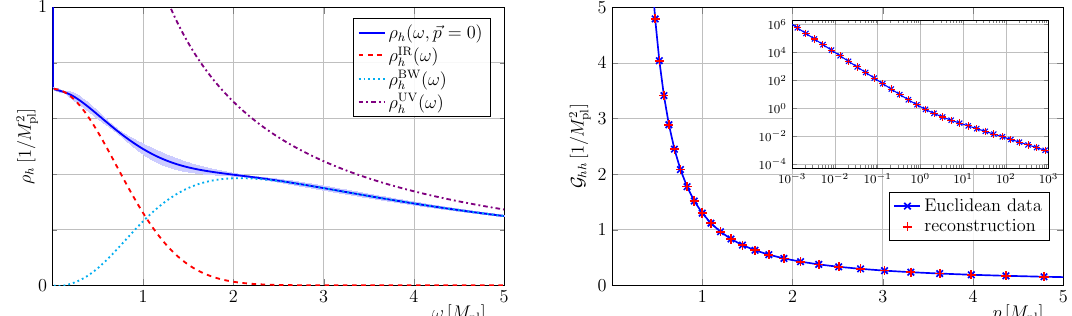
Figure 7: Spectral function of the fluctuation graviton and the reconstructed Euclidean propagator. The reconstruction, the definition of its error, and the error band in Sec.5 are described in Sec. 5.1 and Sec. 5.2. (left) Spectral function of the fluctuation graviton (blue, solid line). It features a δ -function at ω = 0 (massless graviton), and ( ω ) . We also depict the analytic an ensuing smooth multi-particle continuum, ρ cont h IR- and UV-asymptotics (red, dashed and violet, dash-dotted), and the Breit-Wigner part (cyan, dotted). (right) Euclidean fluctuation propagator reconstructed from the spectral function presented in the left panel. The reconstructed and original Euclidean data agree very well on all data points corresponding to a reconstruction error of < 10 − 6 E rel